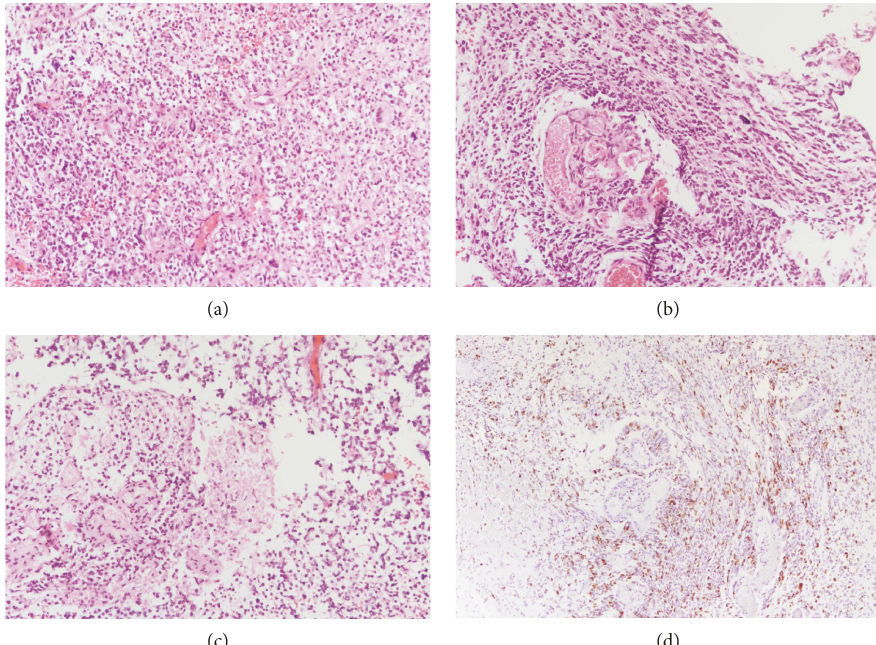
Figure 2: (a)Markedlyincreasedcellularityofneoplasticastrocyteswithnuclearpleomorphismandhyperchromasia(200x),(b)microvascular proliferation (200x), (c) necrosis (200x), and (d) increased proliferation index of tumor cells as revealed by Ki-67 immunostaining (16.3%) (100x).